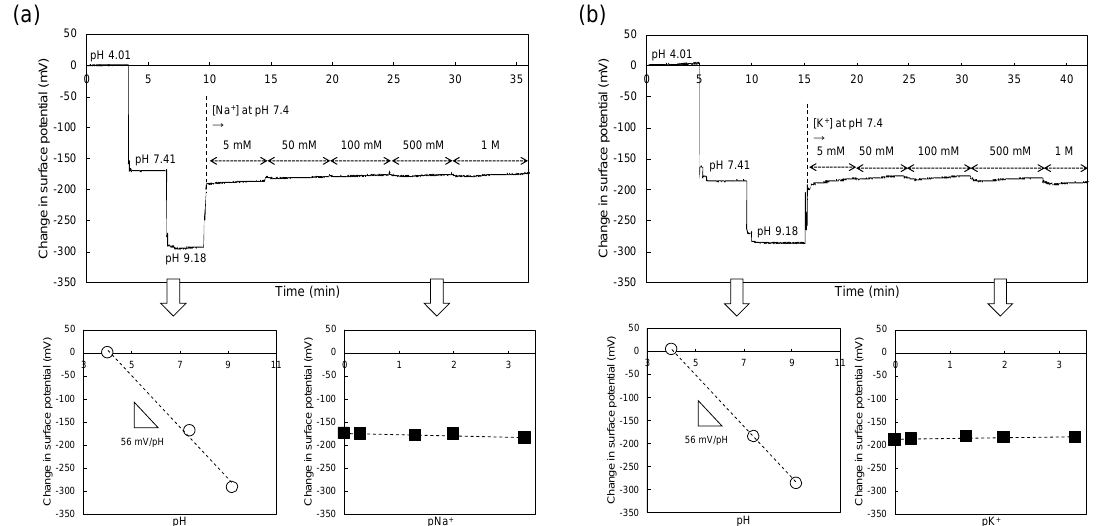
Figure 2. ( a ) Change in surface potential with varying pH and Na + concentration using ISFET sensor. The gate surface potential at a pH of 4.01 was offset to 0 and the change in the potential was measured from a pH of 4.01 to 9.18 and then from a Na + concentration of 5 mM to 1 M. ( b ) Change in surface potential with varying pH and K + concentration using ISFET sensor. The gate surface potential at a pH of 4.01 was offset to 0 and the change in the potential was measured from a pH of 4.01 to 9.18 and then from a K + concentration of 5 mM to 1 M.